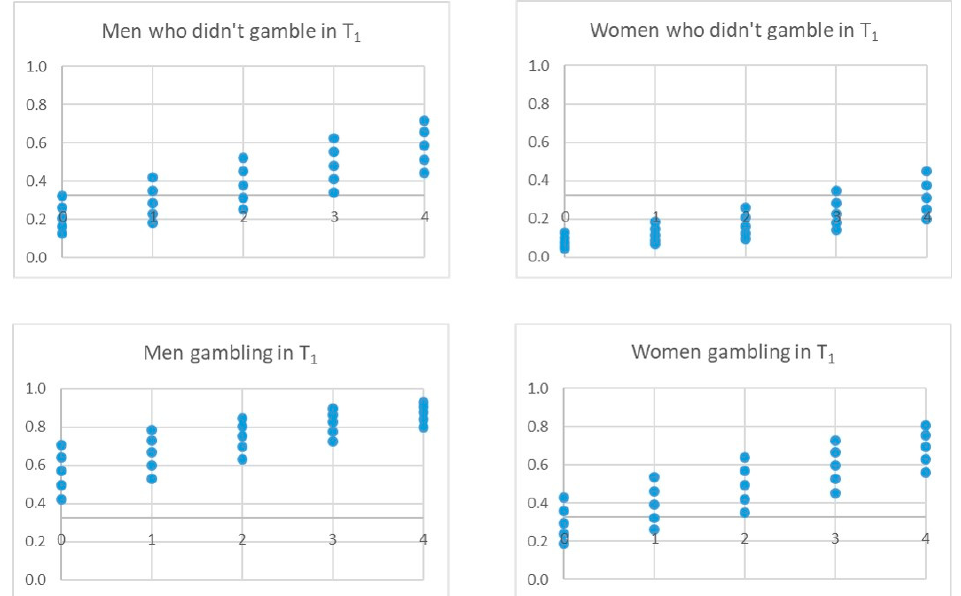
Figure 9. Possible scenarios for model C. Note The X-axis represents the values of the variable risk perception (0, 4). The dots represent the score on the accessibility variable. The horizontal line represents the threshold for a person to be classified as a gambler or not at T 2